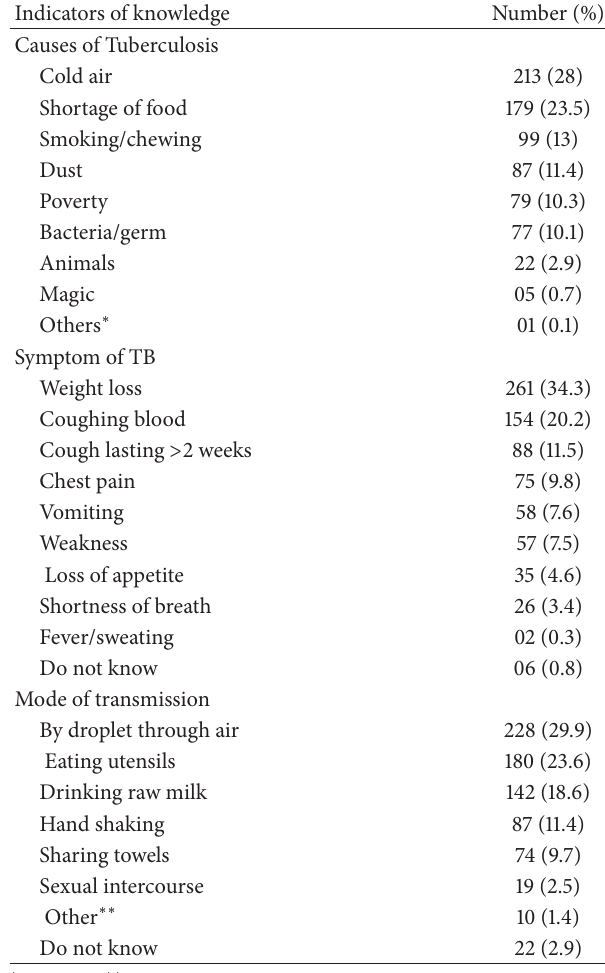
Table 3: Knowledge regarding causes, transmission sources, and TB prevention modes (𝑛 = 762)